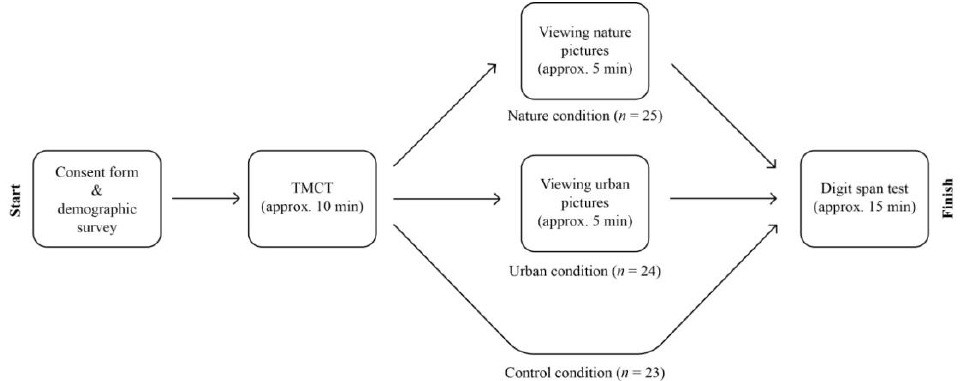
Figure 2. Flowchart of the Research Procedure. TMCT = Trier Mental Challenge Test